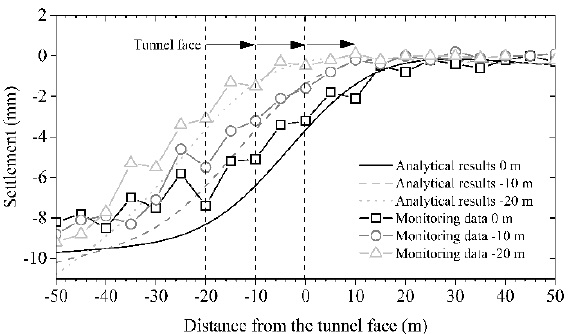
Figure 11. Comparisons of analytical results and monitoring data with shield tunnel advancing.